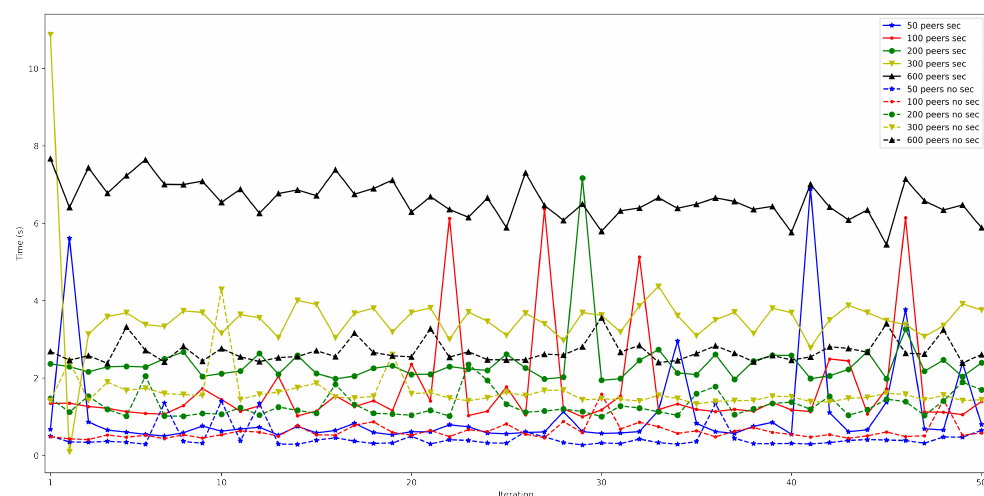
Figure 29. Peer connection time when enabling/disabling TLS